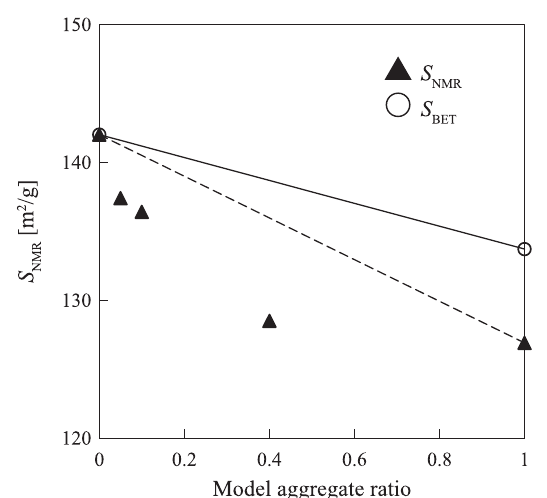
Fig. 11 S NMR of the 10 mass% slurry with different ratios of model aggregate (5 kN). The bold and broken lines are theoretical S BET and S NMR , respectively, which are calculated considering the model aggregate ratio.